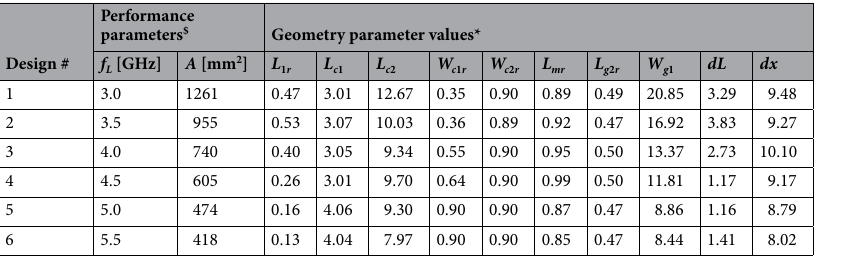
Table 2. Trade-off designs for the CP antenna of Fig. 8: geometry parameter values. $ f L and A stand for the lower end of the operating bandwidth, and the footprint area, respectively. *Absolute parameters in mm; relative parameters (ending with subscript r ) unit-less.